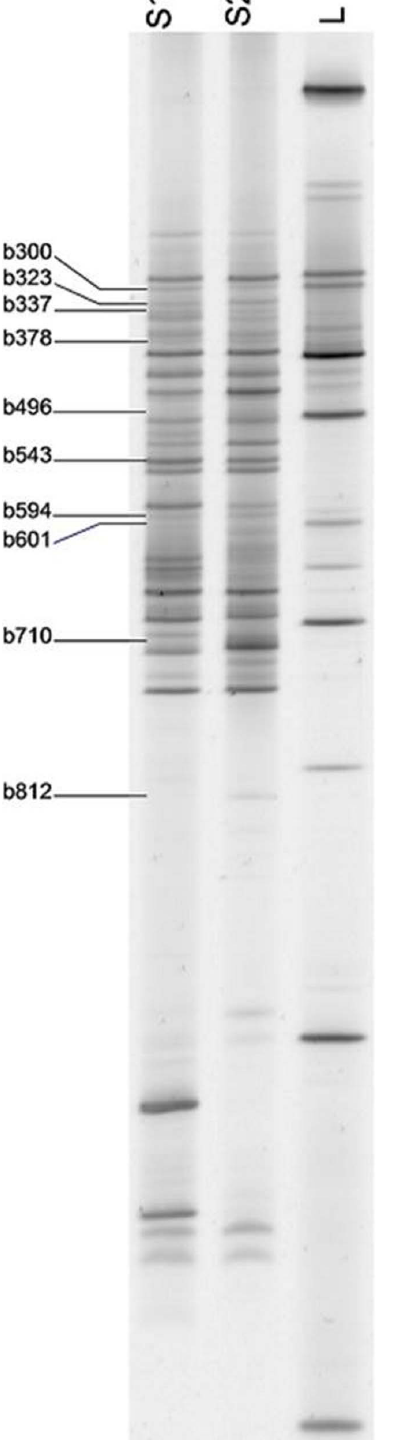
Figure 4. Position of DGGE bands with a significant change after intervention periods in a DGGE gel (L- Marker; S1/S2- Sample 1 and 2).